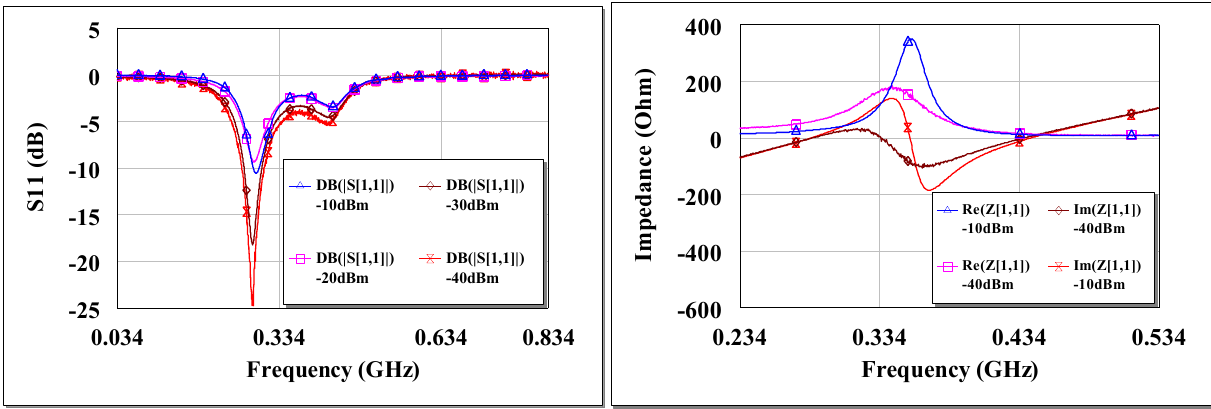
Figure 12. Measured open circuit S of the broadband circuit around 434 MHz at different 11 input power levels from a 50 Ω source ( left ), measured open circuit input impedance at −10 dBm and −40 dBm of the broadband circuit ( right